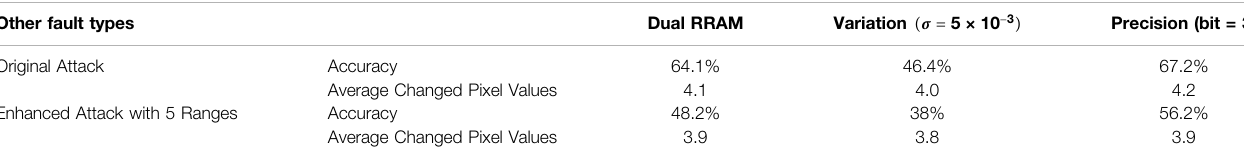
TABLE 3 | Comparison of original and enhanced adversary attacks on hard faults (dual RRAM) and soft faults (normal variation and degraded precision). The fi ve ranges for the enhanced attack are the same as in Table 2 . Other fault